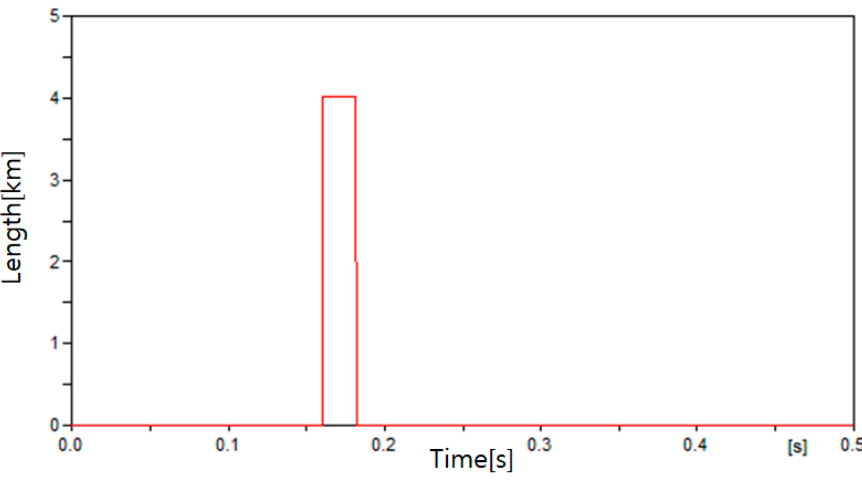
Figure 13. Fault location in Case 3.